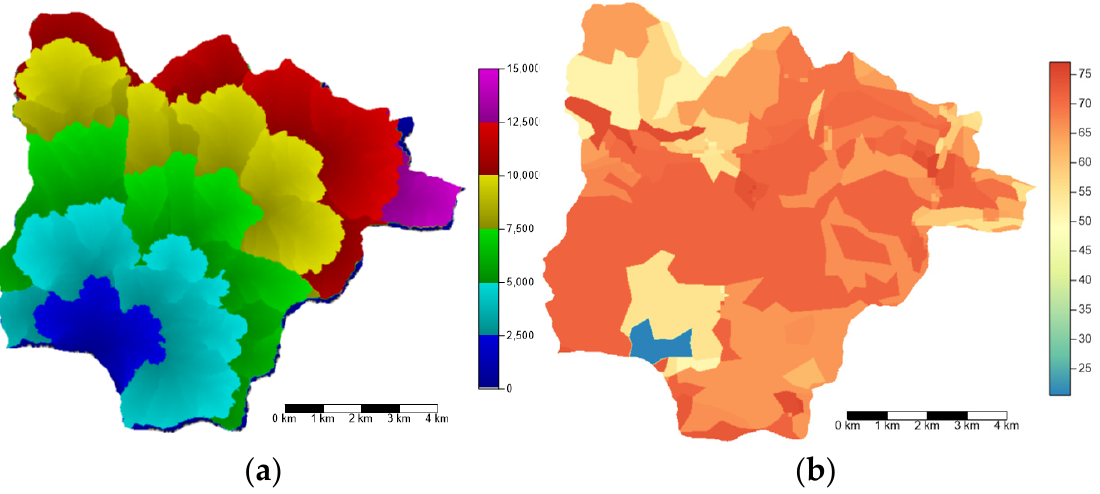
Figure 11. Castello dam catchment: ( a ) Path length map scale in meters); ( b ) CN II spatial distribution map.